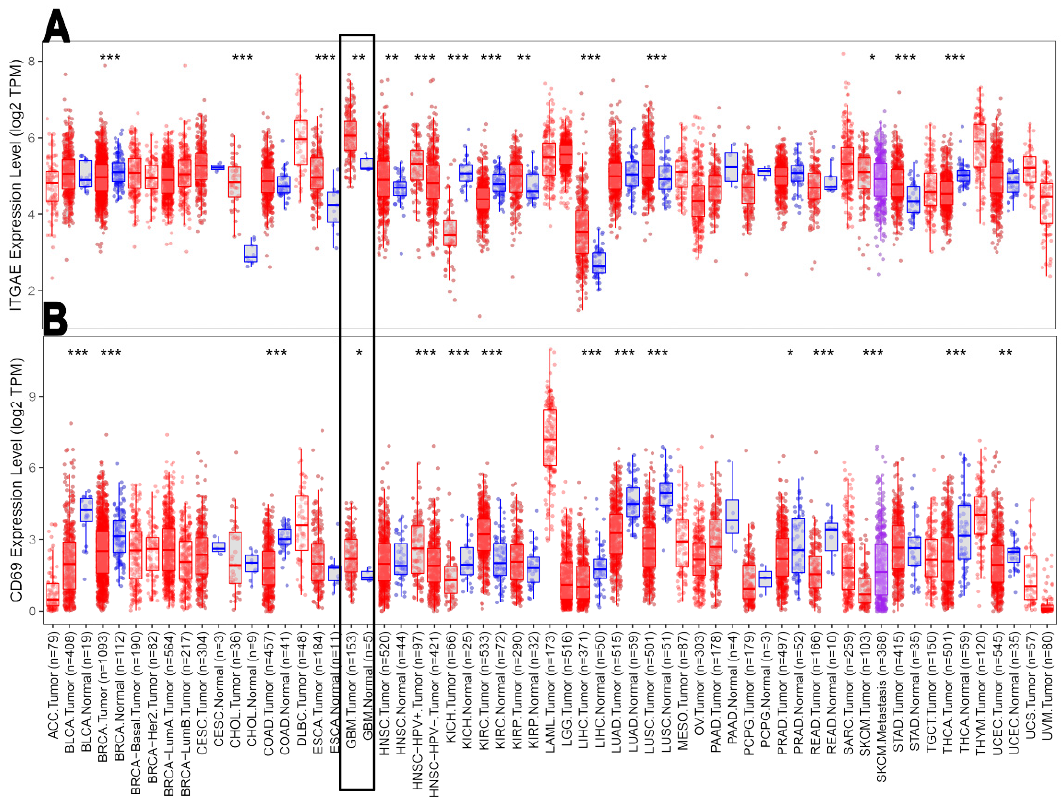
Figure 4. Wilcoxon test from on a cohort of n = 153 GBM patients and n = 5 controls. These two box plots show the differential gene expression between tumor tissue (red dots) and adjacent healthy tissues (blue dots) of ( A ) ITGAE, and ( B ) CD69. *: p < 0.05; **: p <0.01; ***: p <0.001.